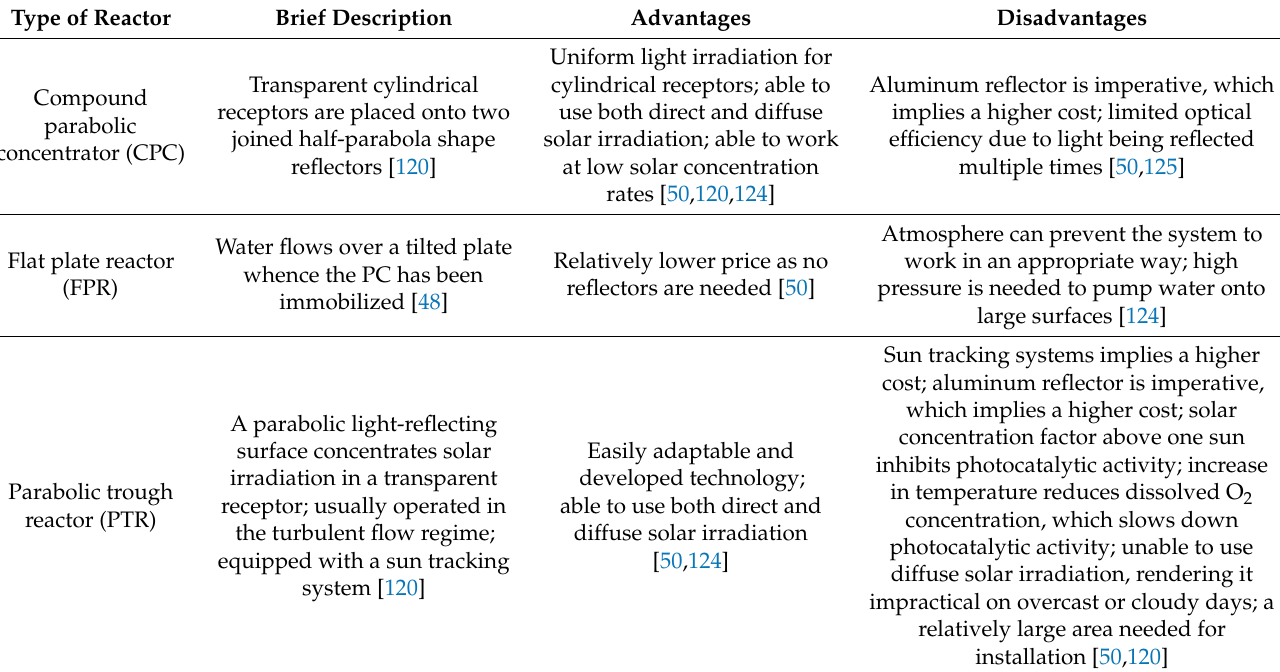
Table 3. Summarized advantages and disadvantages of the most used photocatalytic reactor